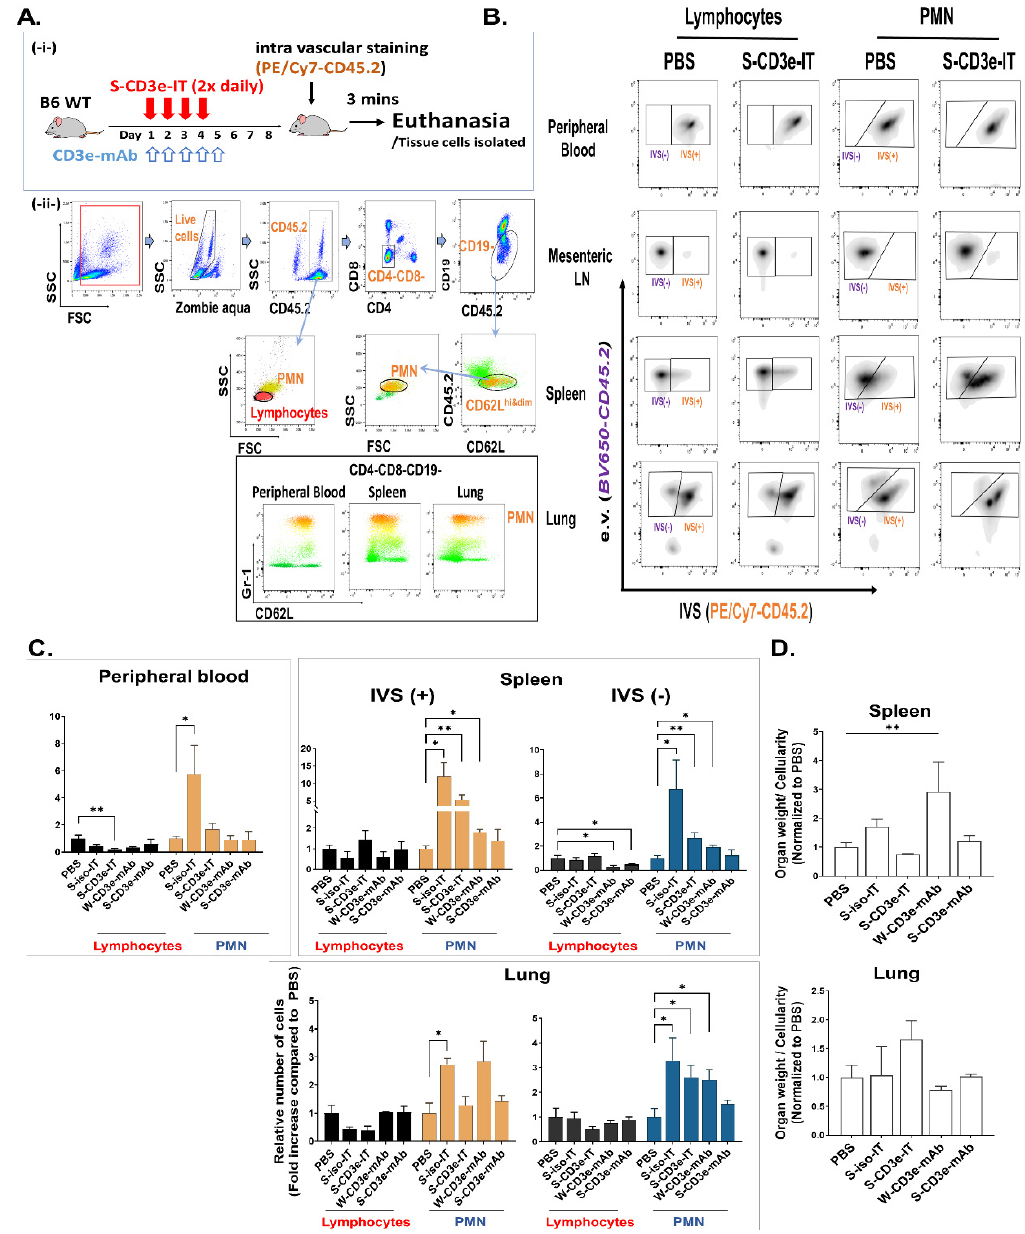
Figure 3. Tracking capillary leakage in mice. ( A ) The upper panel ( -i- ) shows a strategy to track leukocyte migration from the vasculature to the tissue parenchyma, and the lower panel ( -ii- ) shows flowcytometry gating strategy to define polymorphonuclear leukocytes (PMNs) and lymphocytes. The bottom panel shows varying CD62L expression of Gr-1 high PMNs from CD4-CD8-CD19 cells in different tissues. ( B ) Defining intravascular staining antibody positive (IVS+) and negative (IVS–) populations for lymphocytes ( left two columns ) and PMNs ( right two columns ). ( C ) Lymphocyte and PMN population changes in the vasculature (IVS+) and in the tissue parenchyma (IVS–). The total numbers of IVS+ or IVS– lymphocytes (black bars) and PMNs (orange bars for IVS+ PMNs and blue bars for IVS– PMNs) per organ were divided by those of the PBS control (y-axis: fold increase compared to PBS) to estimate the relative changes of these cells after different treatments. IVS+ or IVS– lymphocytes and PMNs are shown side-by-side for the peripheral blood, spleen, and lungs separately. ( D ) The ratios of organ weight to total cell count recovered from the organ (W/N ratios) are shown for the spleen (upper panel) and lung (lower panel). (* p < 0.05 and ** p < 0.01); n = 7 for PBS; n = 3 for S-iso-IT; n = 5 for S-CD3e-IT; n = 3 for W-CD3e-mAb; n = 3 for S-CD3e-mAb).